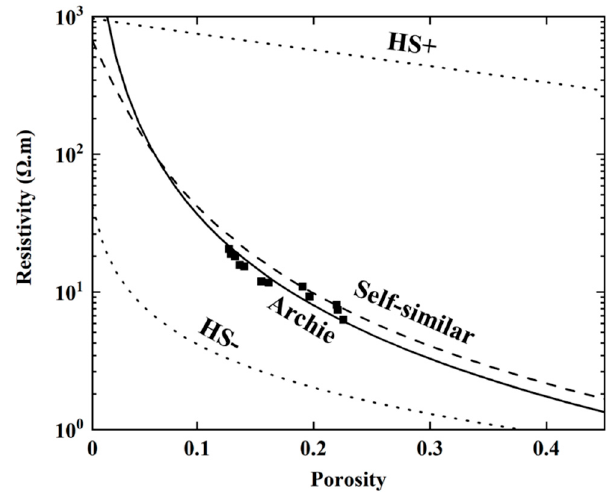
ff erent resistivity-to-porosity Figure 15. Different resistivity ‐ to ‐ porosity models. Figure 15. Di